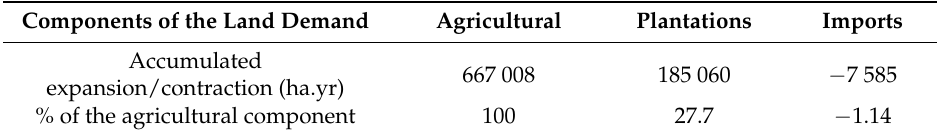
Table 1. Estimates of three components of the land demand associated with the cultivation and export of bananas, pineapples, palm oil, melons, and cassava in Costa Rica. The three components are integrated over 1994–2013 and thus expressed in terms of accumulated area of expansion/contraction over this period (in hectare times